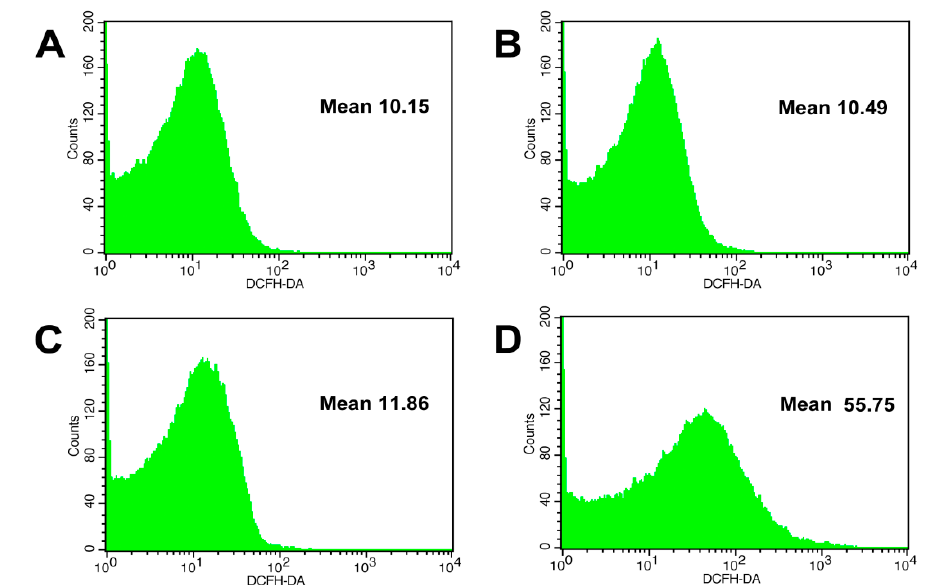
Fig. 4: Effect of Laminaria japonica extracts on reactive oxygen species (ROS) production by 2,7-dichlorofluorescin diacetate (DCFH-DA) staining. DCFH- DA stained cells after treatment with 0 mg/mL L. japonica extracts (control; A); DCFH-DA stained cells after treatment with 0.02 mg/mL L. japonica extracts (B); DCFH-DA stained cells after treatment with 0.03 mg/mL L. japonica extracts (C); DCFH-DA stained cells after treatment with 0.04 mg/ mL L. japonica extracts